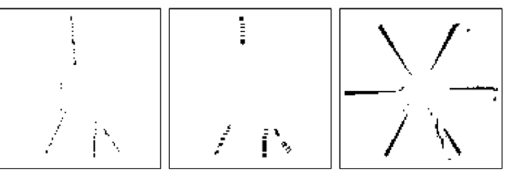
Figure 15. Siemens Star that is parallel to the image plane of the TI OPT8241 ToF sensor without motion ( left ), with synthetic motion blur ( middle ), with real motion blur ( right ).